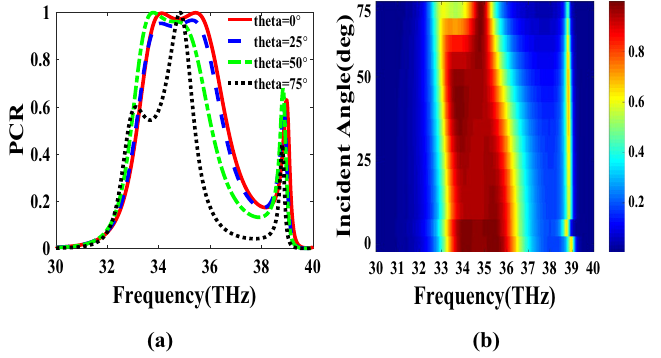
Figure 9. PCR of the first structure for different incident angles.